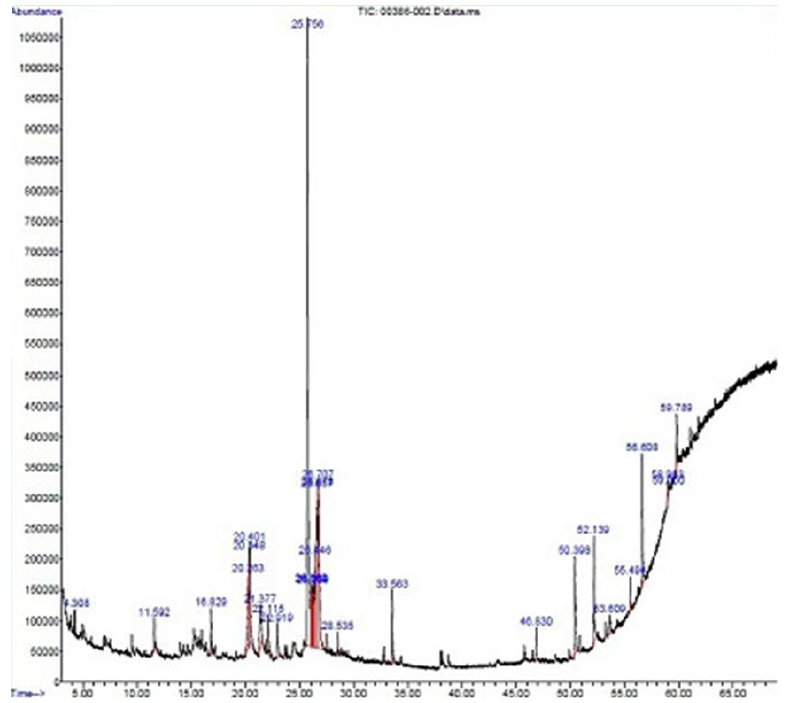
Fig. 1.The GC-MS Chromatogram of Glycyrrhiza glabra extract showing the peaks of the test compounds Vs retention time in minutes.